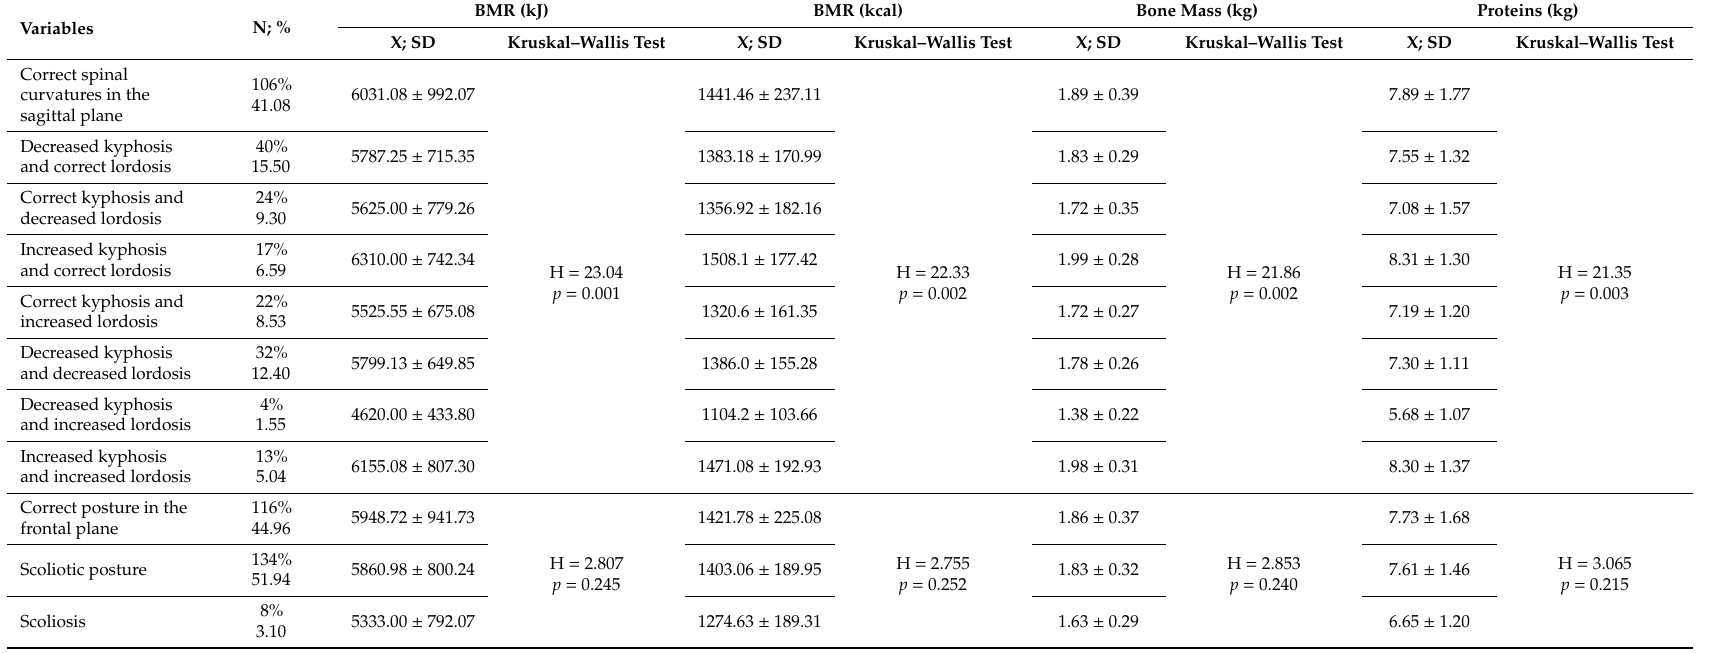
Table 4. Body posture defects according to body